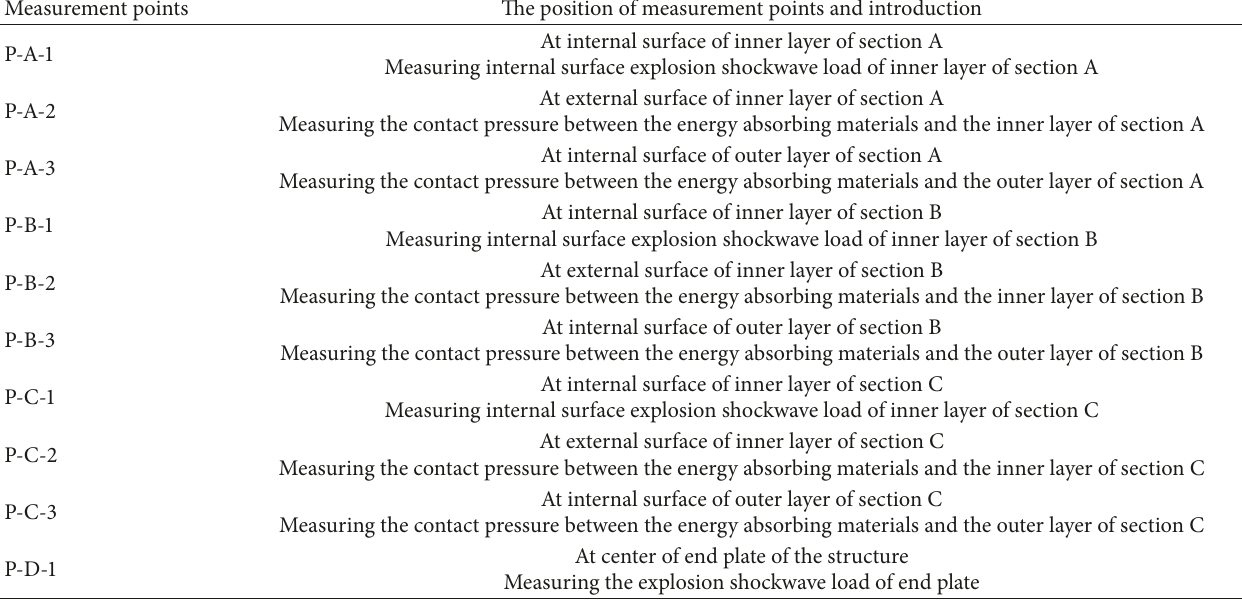
Table 3: Description of pressure measurement points.